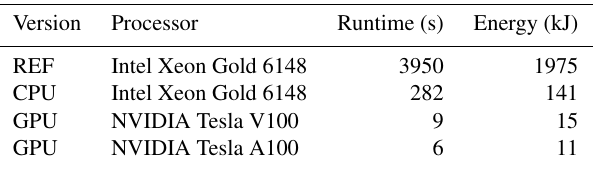
Table 3. Time to solution and estimated energy to solution compar- ison between GPU version, CPU version, and the reference imple- mentation (Hoffmann,